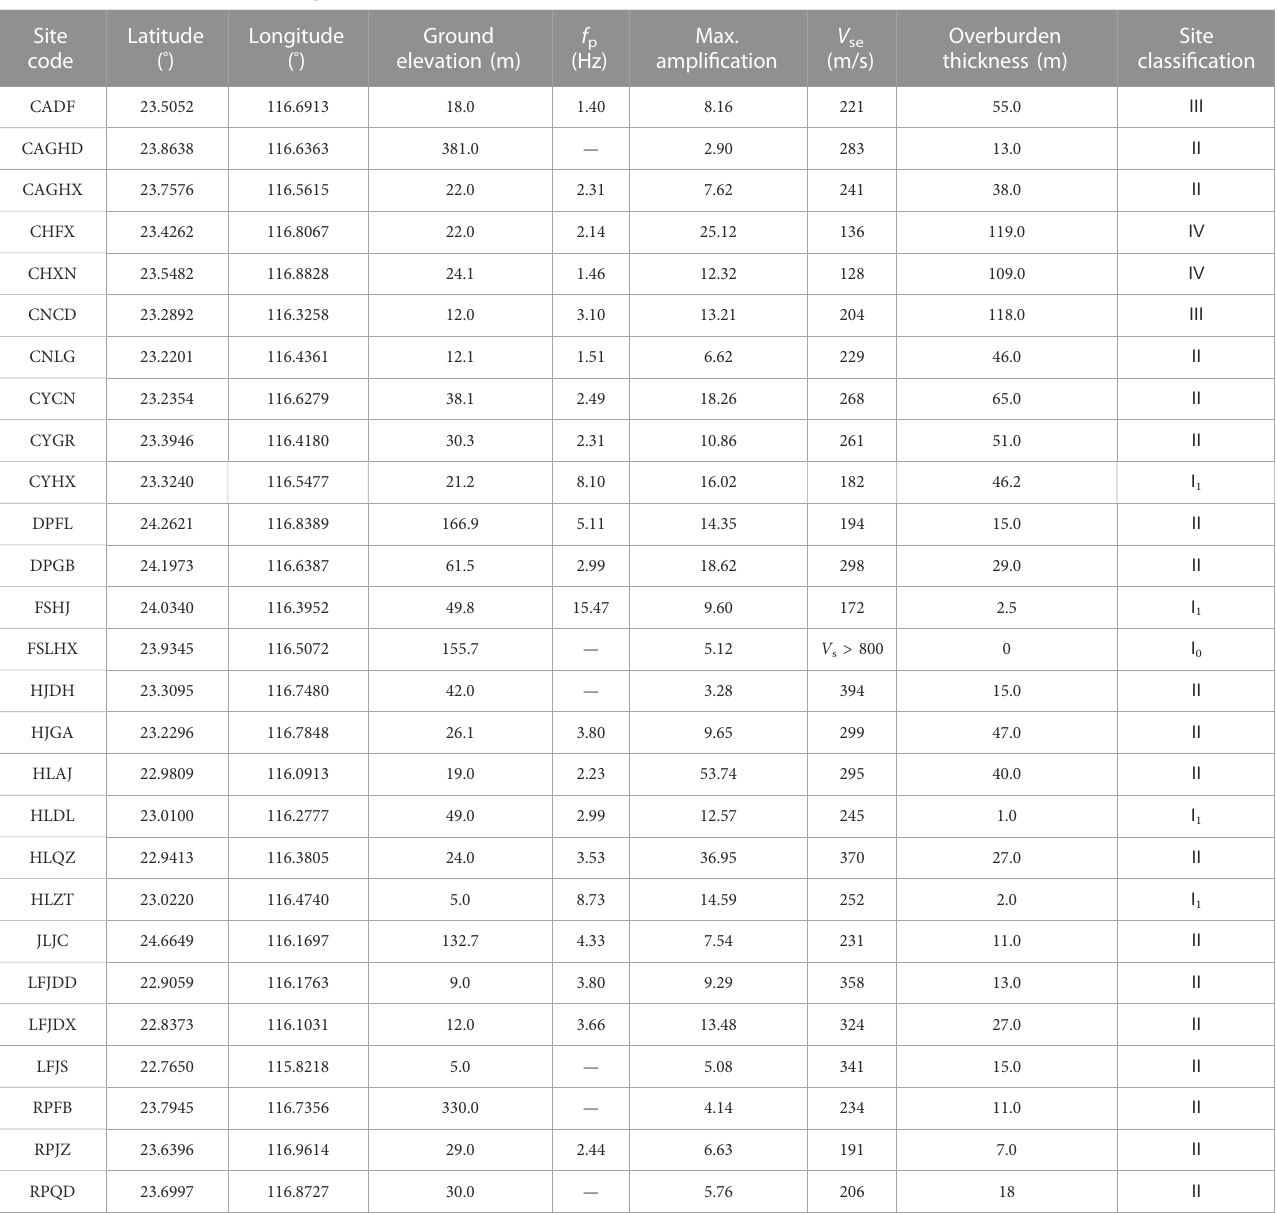
TABLE 2 Site conditions and calculated parameters at 27